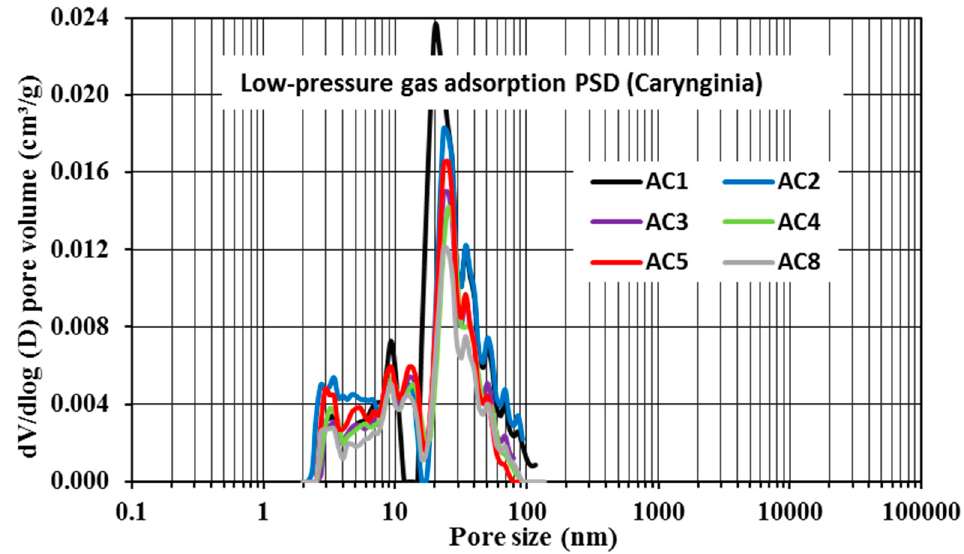
Figure 6. Carynginia pore size distribution (PSD) derived from low-pressure N 2 gas adsorption based on BJH theory.